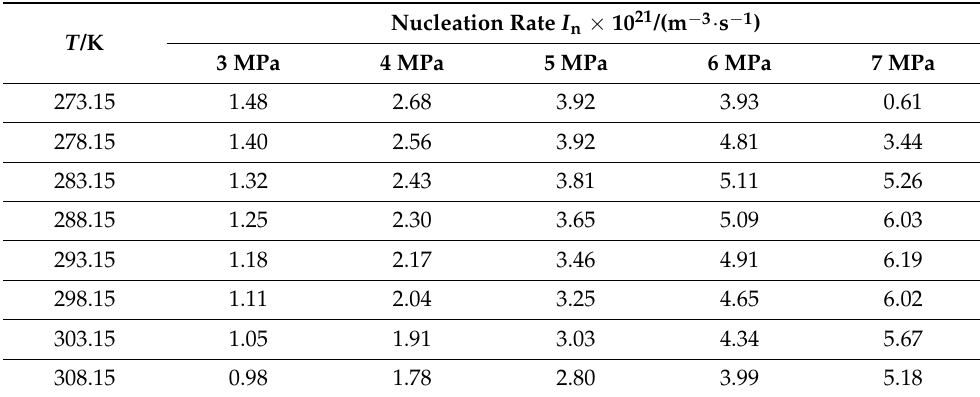
Table 6. Calculation results of elemental sulfur nucleation rate in gas 3. T